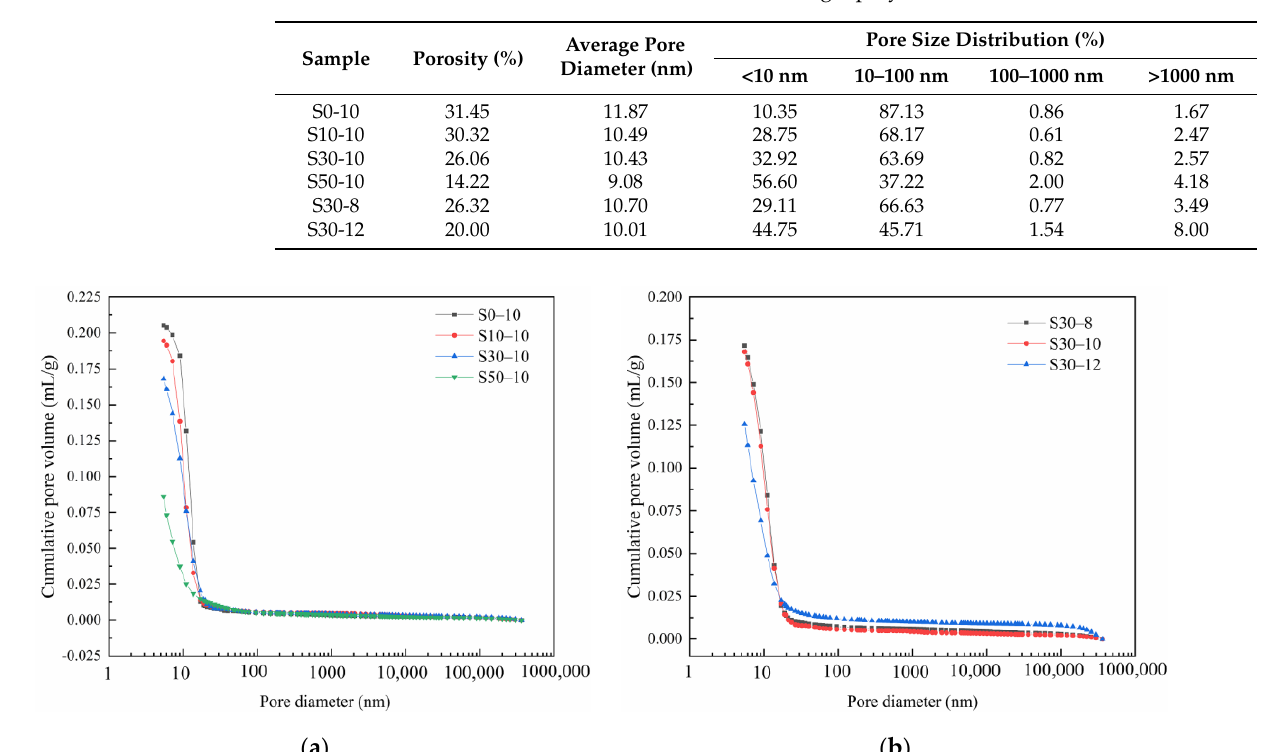
Table 3. Pore size distribution of the metakaolin-based geopolymers.